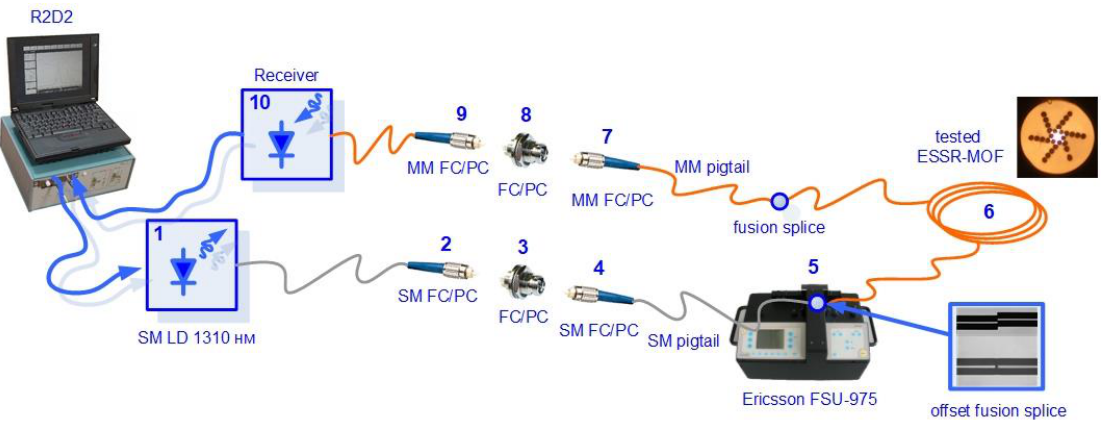
Figure 11. Simplified block scheme of DMD analyzer workstation R2D2 (ESSR-MOF DMD map measurement setup).